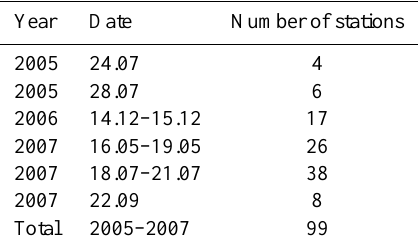
Table 1. Period of observations and number of hydrographical pro- files obtained near the southern coast of Crimea.